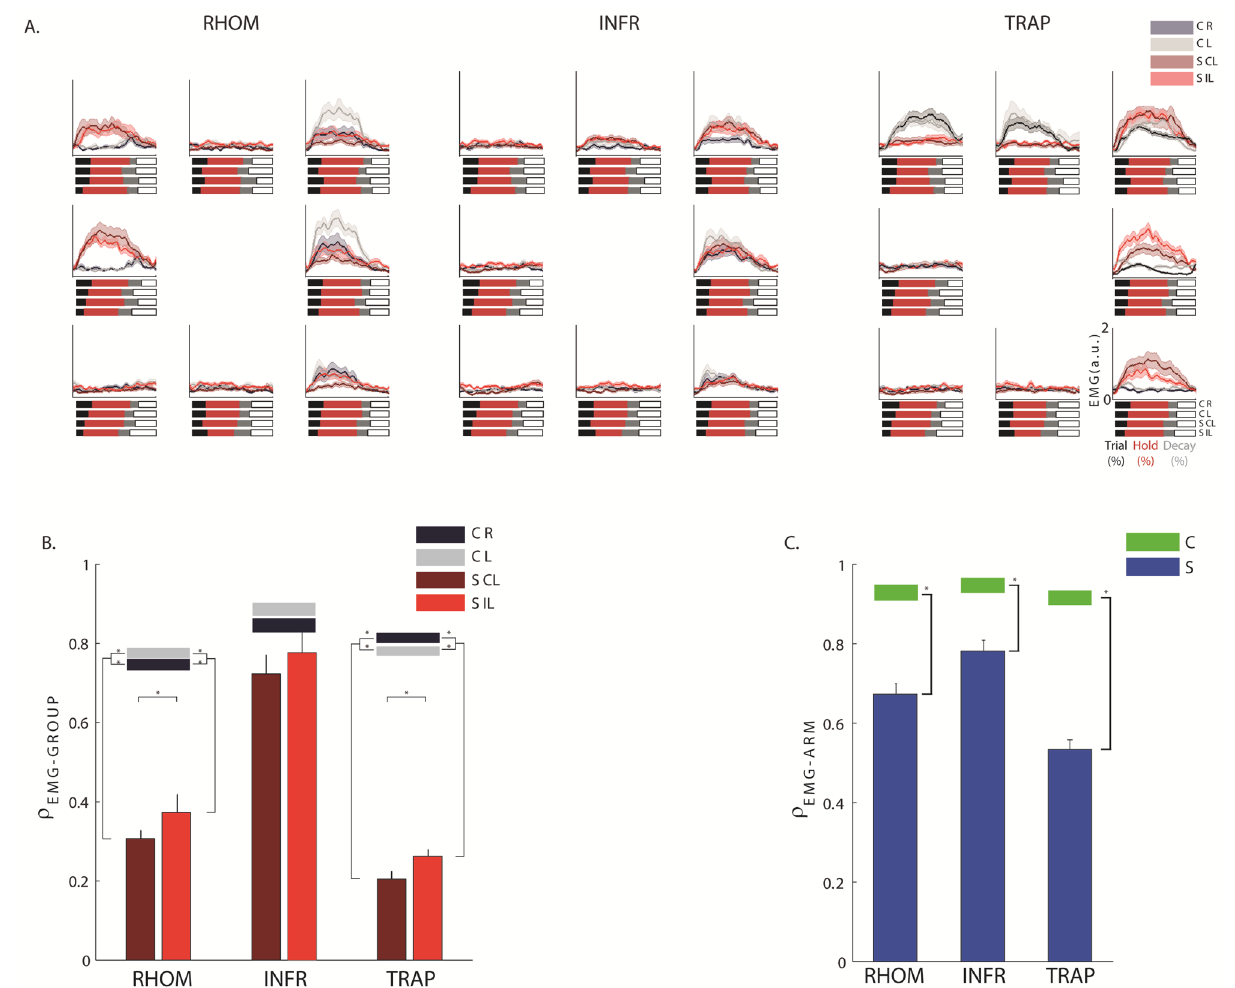
Figure 4. Top panels: Normalized EMG envelopes. Activation of the rhomboid major (RHOM, first column), Infraspinatus (INFR, second column) and upper trapezius (TRAP, third column) in the eight directions. The blank and red line respectively represents the mean activation for control subjects (C) and stroke subjects (S). Darker and brighter colors represent the right (R) and left (L) arm of C and contralesional (CL) and ipsilesional (IL) arm of S. The shaded area indicates the standard error. Bars to the bottom of EMG envelopes denote trial- to-release transition time. Bottom panels: Mean and standard error of the Pearson correlation comparing the EMG envelopes of the two groups (ρ EMG-INTER-GROUP , B ) and the arms (ρ EMG-ARM , C ). The darker and lighter colors in the B panel represent respectively the contralesional (CL) and ipsilesional (IL) arm for stroke subjects (S). The black (right arm) and grey (left arm) bars indicate the intra-group similarity (ρ EMG-INTRA-GROUP , B ), in terms of ρ 2D , between the EMG envelopes of the control (C) group. The blue and green colors in the ( C ) panel represent respectively the control (C) and stroke subjects (S). The error bars indicate the standard error of the indicators. * indicates significant differences (p <